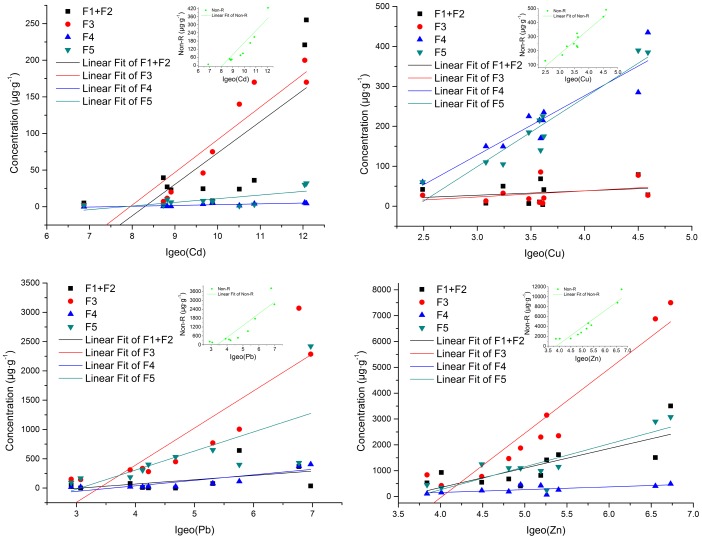
Relationships between the speciation concentrations and the corresponding Igeo.